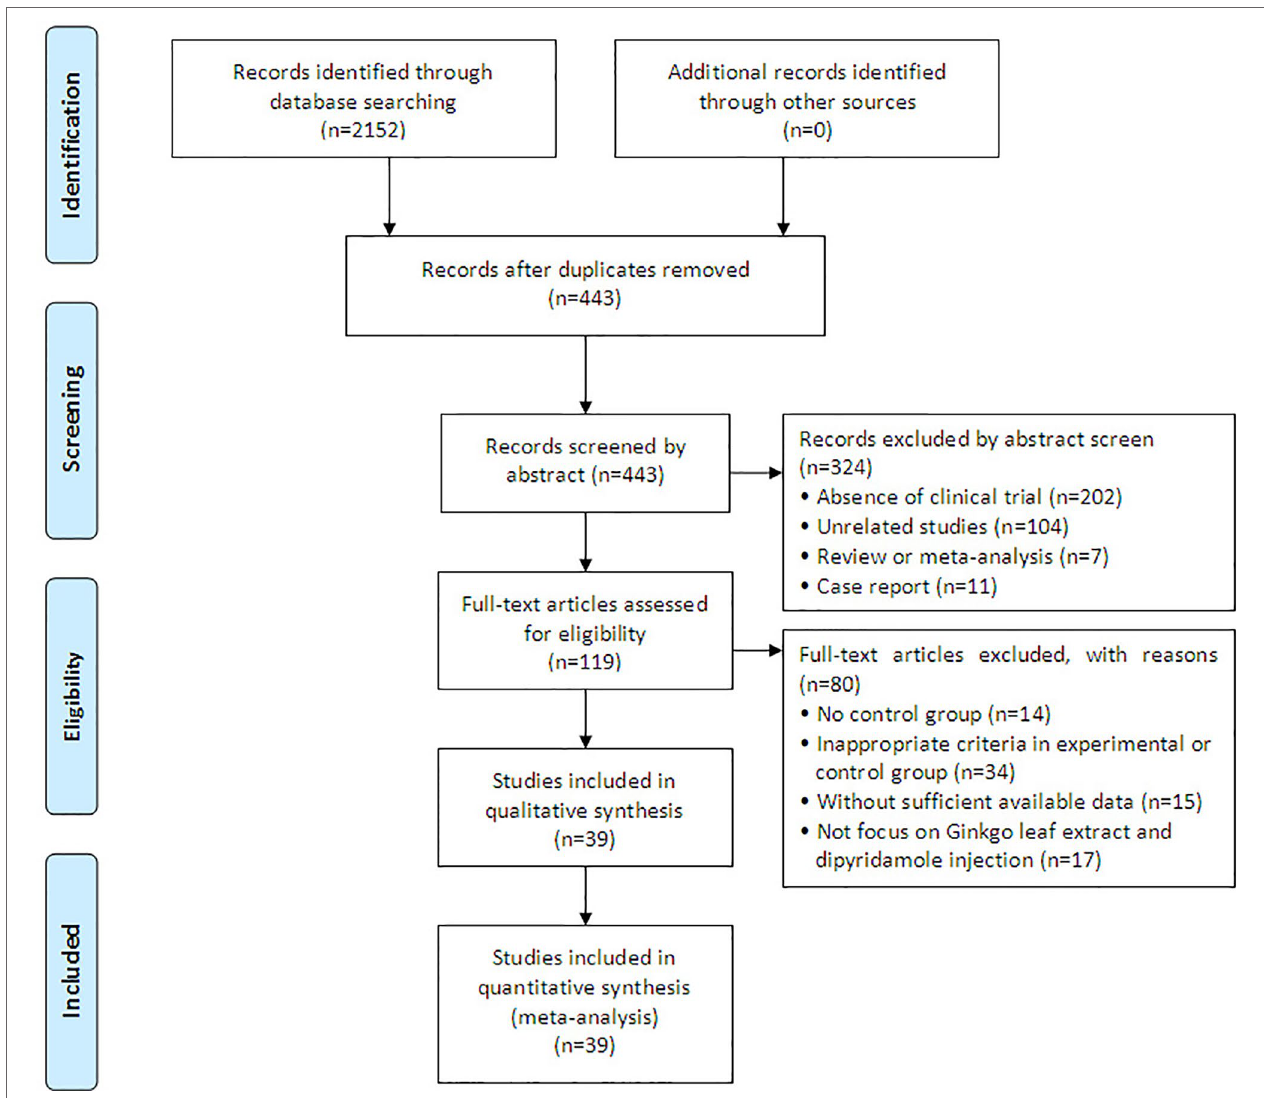
FIGURE 1 | Study selection process for the